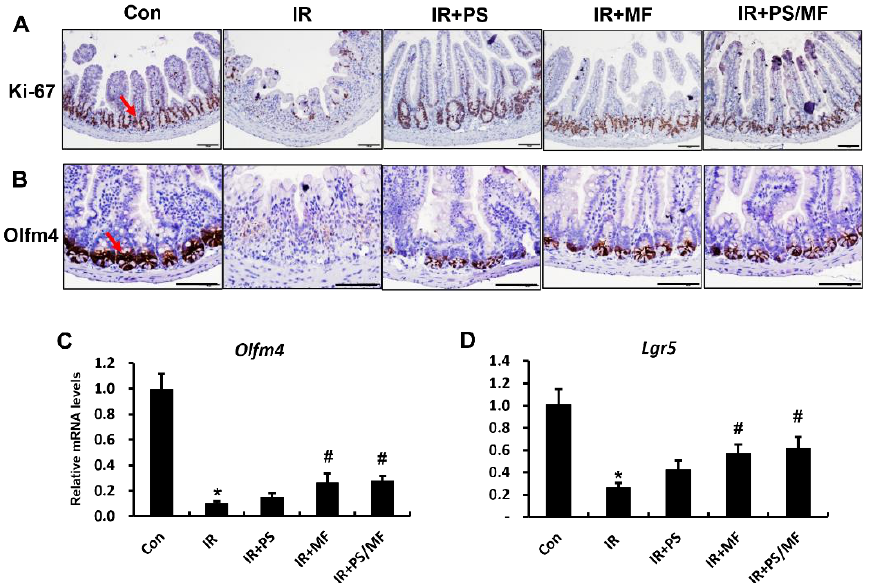
Figure 3. Effect of combined pravastatin and metformin treatment on epithelial cell proliferation in radiation-induced intestinal injury. Immunohistochemical analysis of ( A ) Ki-67 and ( B ) olfactomedin 4 (Olfm4) in small intestine of control (Con), irradiated (IR), pravastatin-treated IR (IR + PS), metformin-treated IR (IR + MF), combined PS and MF-treated IR (IR + PS/MF) groups. Bar = 100 μm Red arrows indicate Ki-67 and Olfm4 positive cells. mRNA levels of ( C ) Olfm4 and ( D ) leucine rich repeat containing G protein coupled receptor 5 (Lgr5) of Con, IR, IR + PS, IR + MF, IR + PS/MF groups. Data are presented as the mean ± standard error of the mean; n = 5 – 6 mice per group. * p < 0.05 compared to the control; # p < 0.05 compared to the IR group.